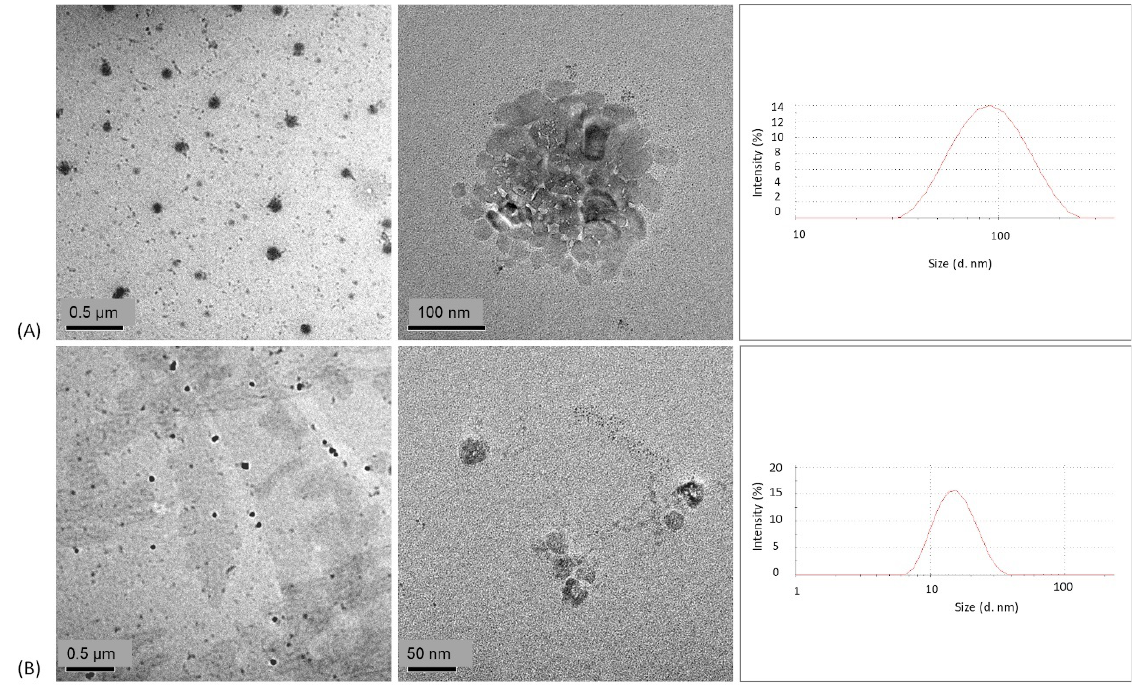
Figure 5. TEM images and size distribution histogram of ( A ) DMC and ( B ) BDM–loaded PLHNs.